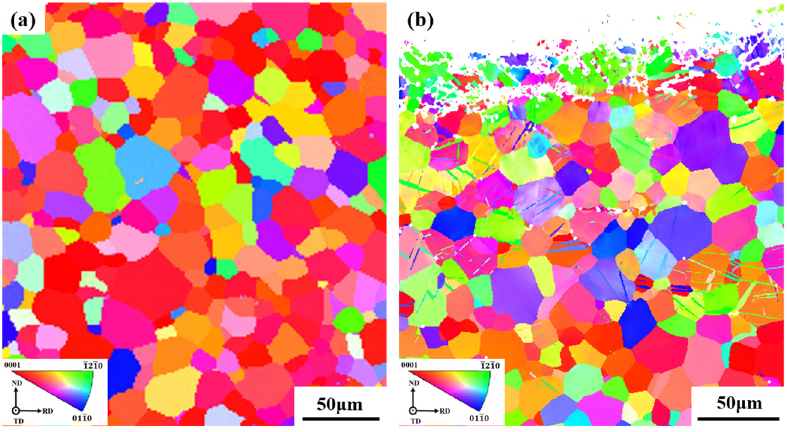
Figure 3. Inverse pole figure images of ( a ) as-received; ( b ) HESPed.